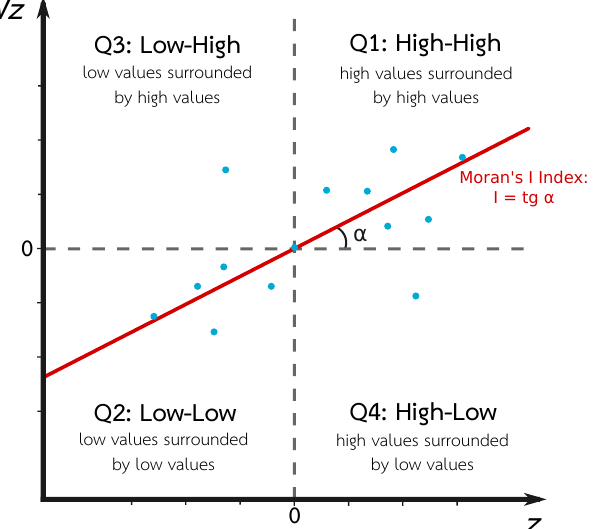
Figure 4. Moran Scattering Diagram. Source: Adapted from References